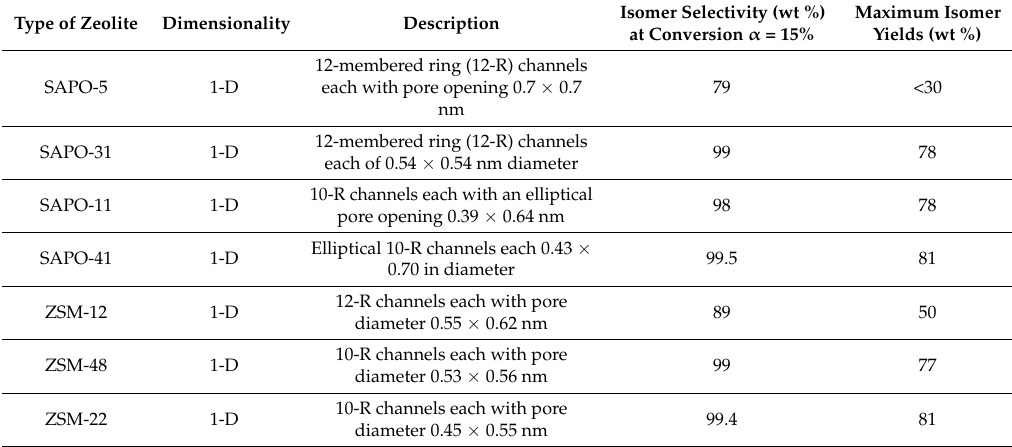
Table 5. Isomer selectivities of SAPO and ZSM zeolite types for n -octane hydroisomerization. Reaction conditions: T R = 250 ◦ C, H 2 /HC = 60, conversion α = 15%, thermodynamic value 2-MeC 7 /3-MeC 7 = 0.90 (modified from Reference